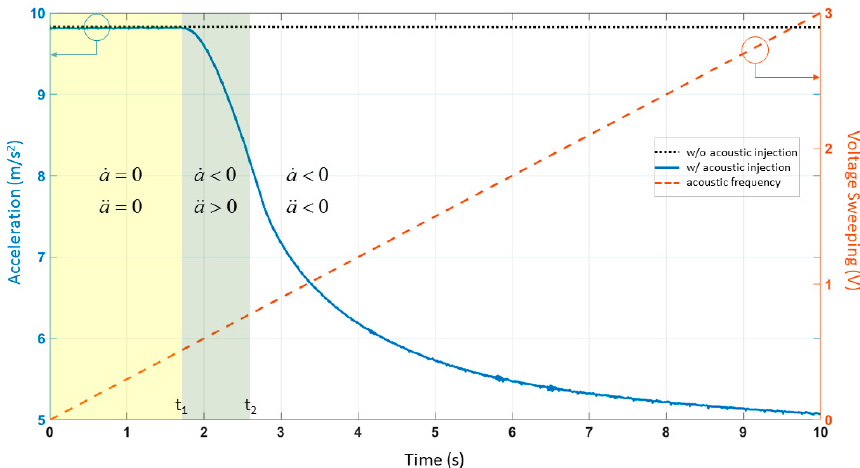
Figure 3. The output acceleration of ADXL103 under the acoustic injection attack with amplitude sweeping at frequency of 5245 Hz.